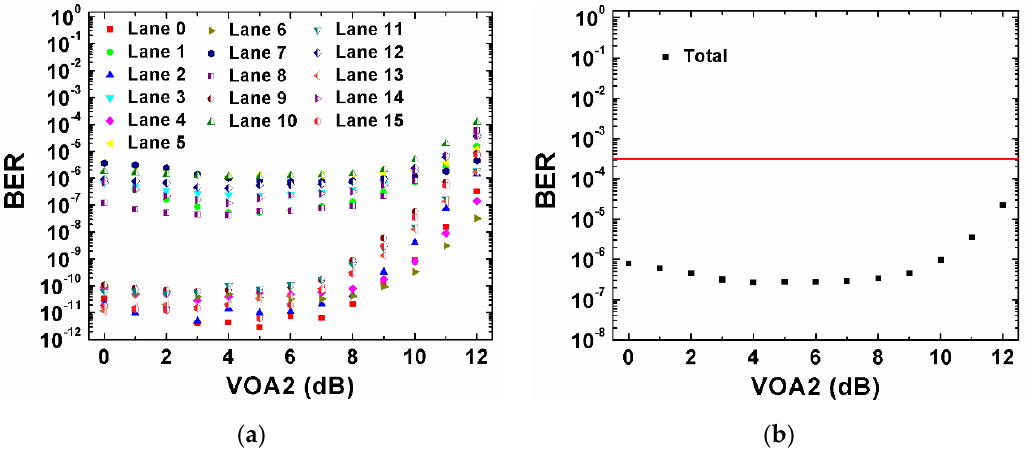
Figure 10. Back-to-back performance for interoperation of two CFP8-LR8 modules. The signal is transmitted from the Tx of the second module to the Rx of the first module: ( a ) BER versus VOA2’s attenuation for 16 individual electrical lanes; ( b ) total BER vs. VOA2’s attenuation. The threshold for UCW is shown as the red line.